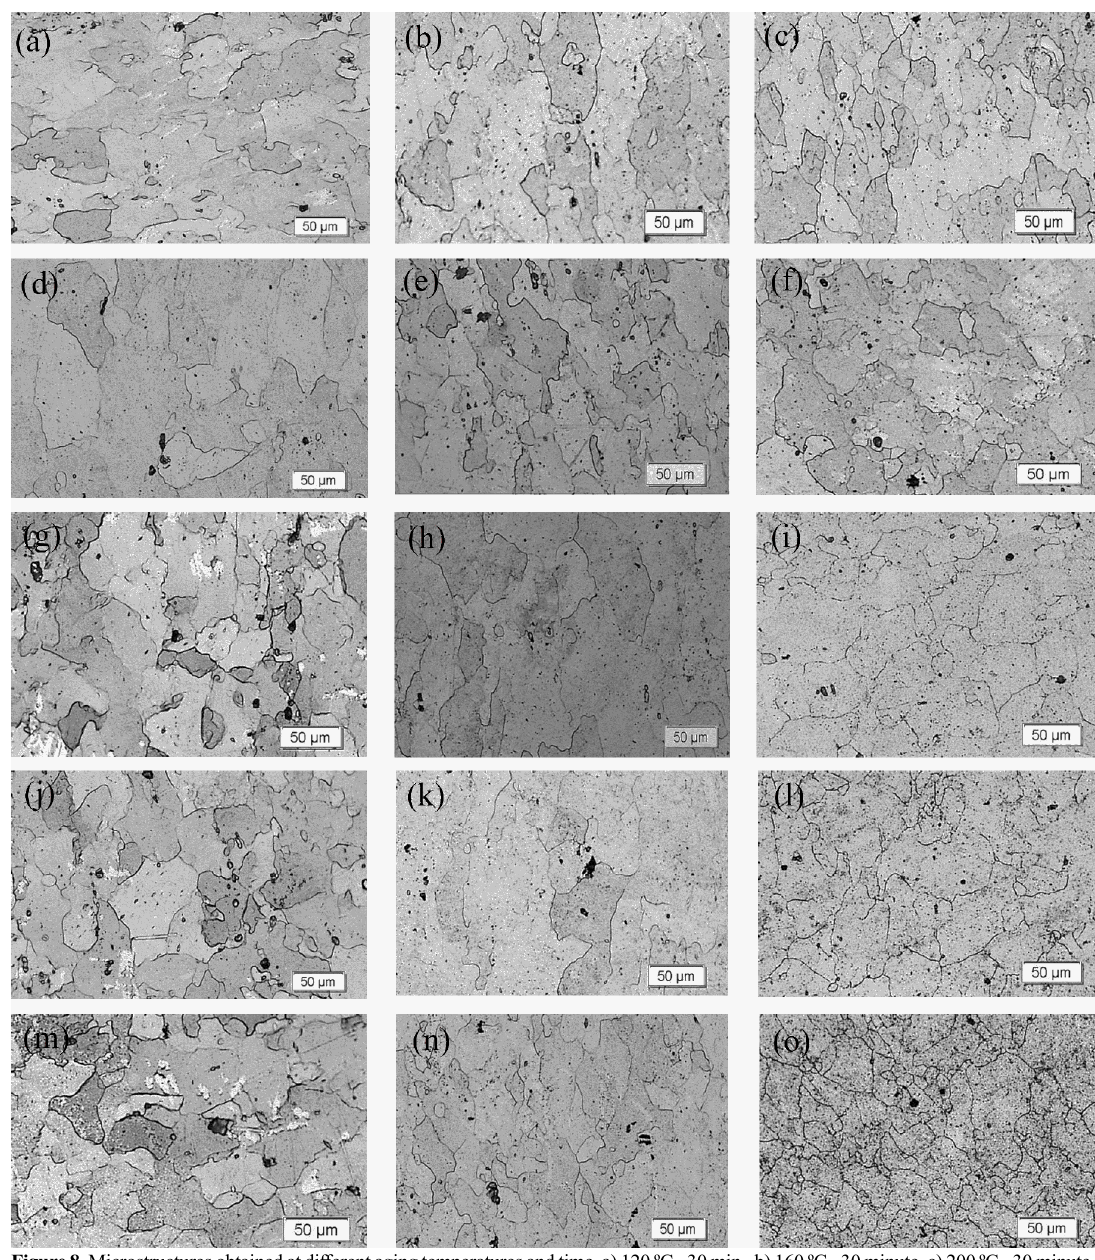
Figure 8. Microstructures obtained at different aging temperatures and time, a) 120 ºC - 30 min., b) 160 ºC - 30 minute, c) 200 ºC - 30 minute, d) 120 ºC -90 minute, e) 160 ºC -90 minute, f) 200 ºC -90 minute, g) 120 ºC -180 minute, h) 160 ºC -180 minute, i) 200 ºC -180 minute, j) 120 ºC -1080 minute, k) 160 ºC -1080 minute, l) 200 ºC -1080 minute, m) 120 ºC -2880 minute, n) 160 ºC -2880 minute, o) 200 ºC -2880